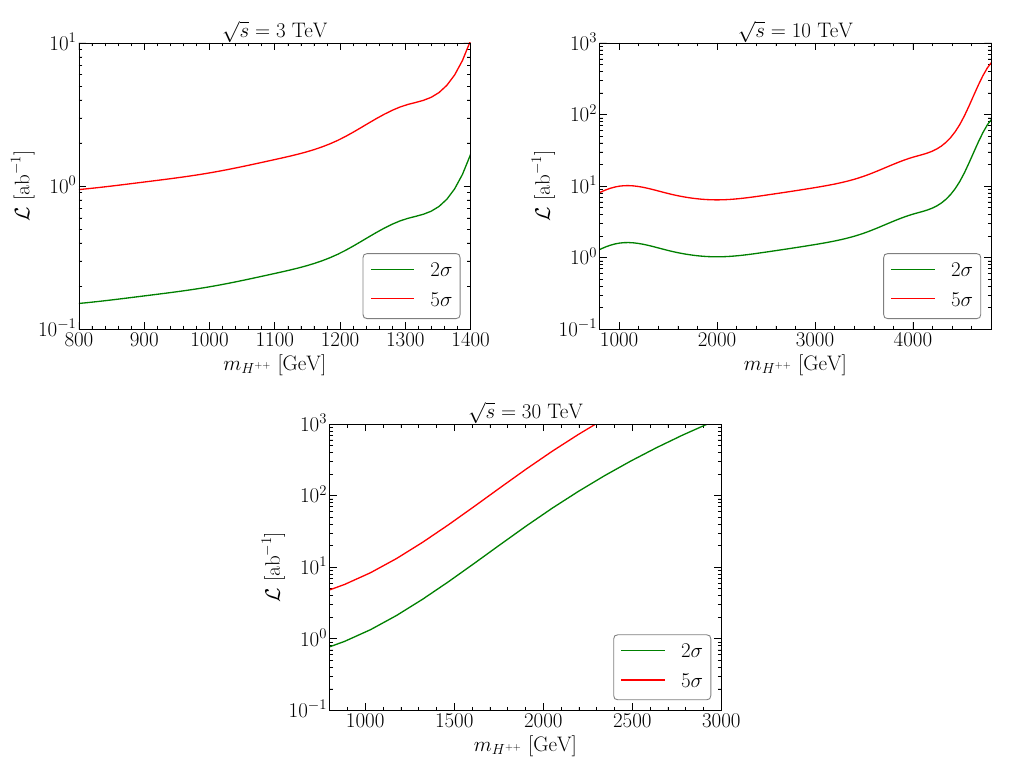
for H ++ √ s = 3 TeV, 10 TeV and 30